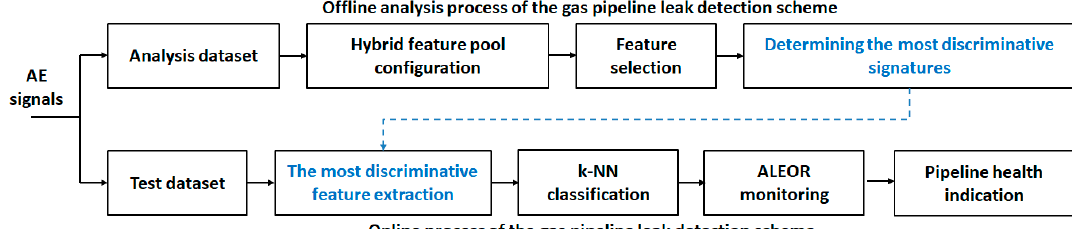
Figure 4. Entire flow diagram of the gas pipeline leak detection.